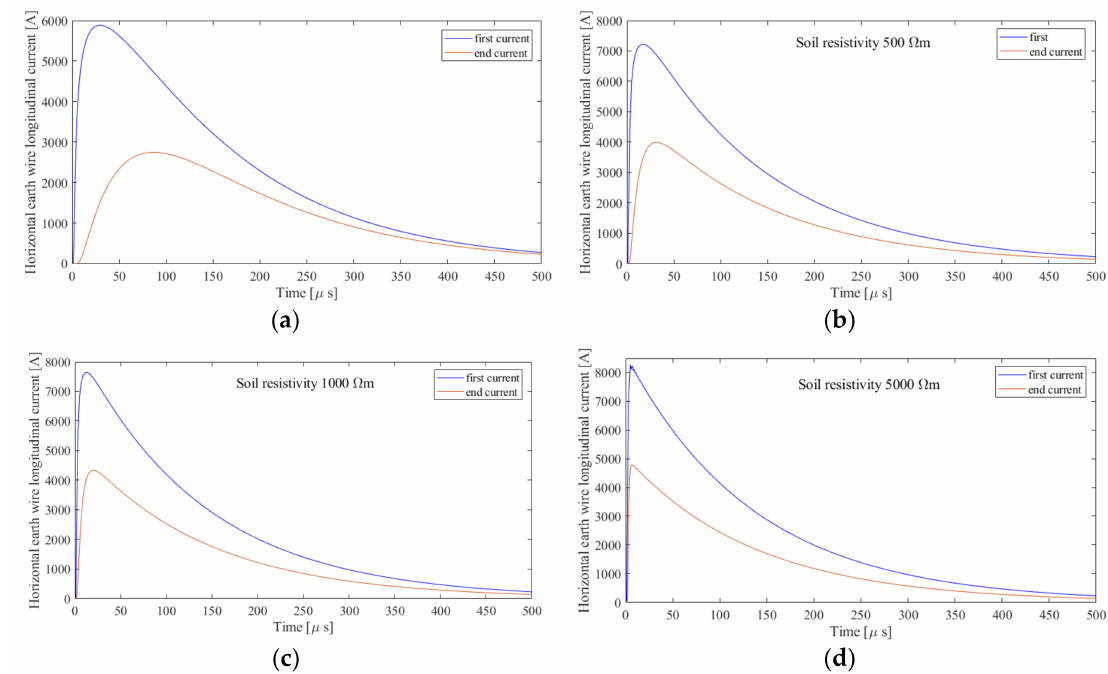
Figure 7. Current time profiles in the copper rope. The distance between the substations is set equal to 100 m. ( a ) soil resistivity 100 Ω · m; ( b ) soil resistivity 500 Ω · m; ( c ) soil resistivity 1000 Ω · m; ( d ) soil resistivity 5000 Ω · m.